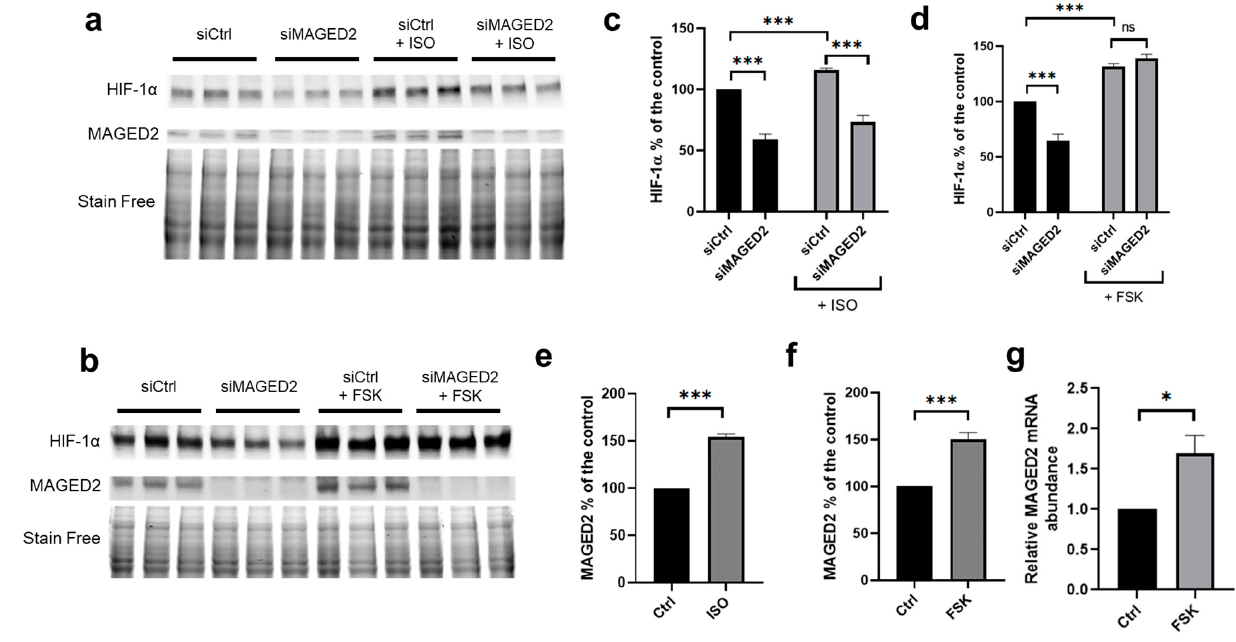
Figure 4. Forskolin reverses the effect of MAGED2 knockdown on hypoxic HIF-1 α induction and induces MAGED2 transcription: ( a , b ) HeLa cells were transfected with control (siCtrl) or MAGED2 (siMAGED2) siRNA. Cells were exposed to the hypoxia mimetic CoCl 2 (300 µM) and with ( a ) 10 µM isoproterenol (ISO) or ( b ) 10 µM forskolin (FSK) for 14–16 h. Total cell lysates were separated by SDS-PAGE and probed with anti-HIF-1 α and MAGED2 antibodies. ( c , d ) Densitometric analysis of HIF-1 α immunoblot presented in ( a , b ), respectively. ( e , f ) Densitometric analysis of MAGED2 immunoblot presented in ( a , b ), respectively. ( g ) HEK293 cells were treated with CoCl 2 for 14 h and then treated with DMSO or Forskolin 10µM for 2 h. Total RNA was extracted, and the relative mRNA amount of MAGED2 was determined by qRT-PCR. Statistical significance was determined by unpaired two-sided Student’s t -test ( c – g ). All Western blots shown are from the same experiment, which is a representative example of three independent experiments. Bar graphs show mean ± SEM. * p ≤ 0.05 and *** p ≤ 0.001.